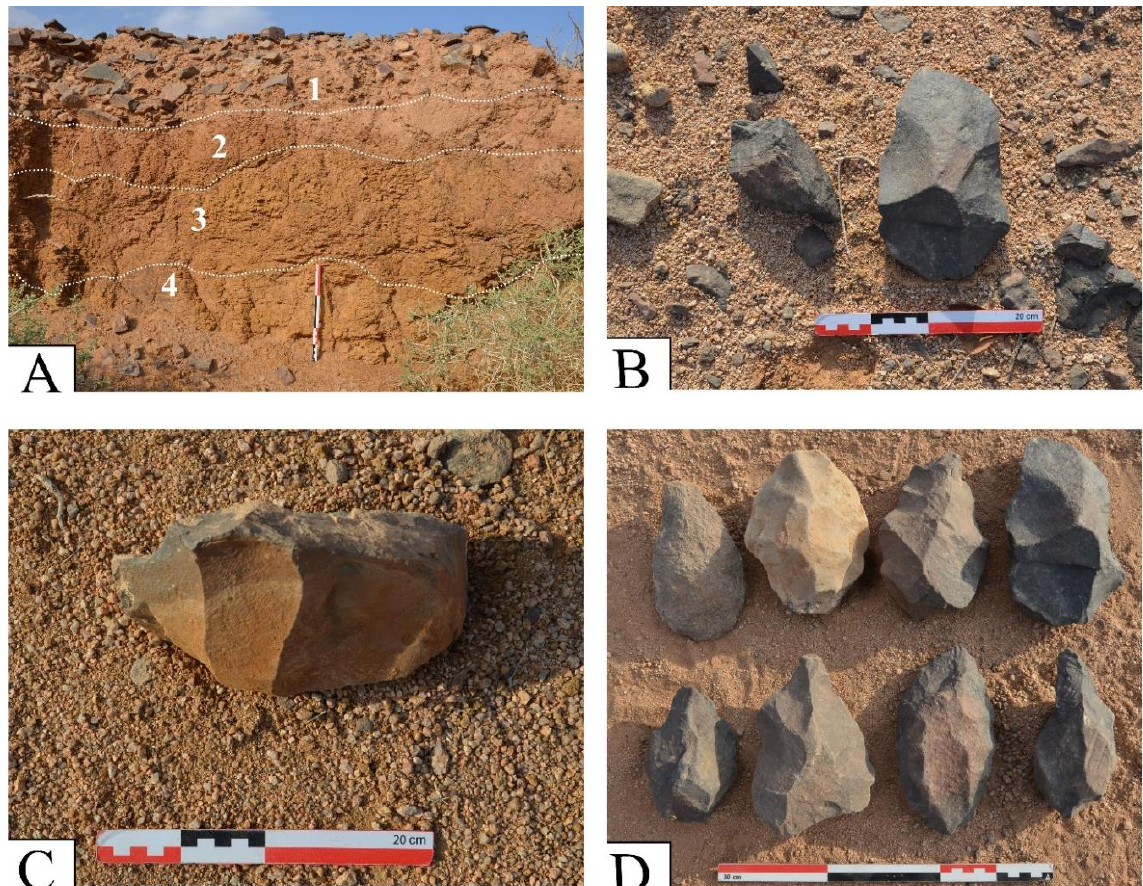
Figure 4: A) A recent water channel shaft profile, depth 1.5 m. 1: Weathered layer from loose fine clay and sand where Acheulean artefacts were buried. 2: Soft sediment with small amounts of Acheulean cores and flakes. 3: Reddish loam matrix of consolidated palaeosol, non-artefacts bearing. 4: Compact loam soil possibly above the bedrock, in depth 1.3 m, non-artefacts bearing. B) Large cutting handaxe made from fine basalt on the surface. C) Acheulean core showed several scars provided number of removals from multiple striking platforms. D) Different types and sizes of handaxes gathered from the surface for basic metric